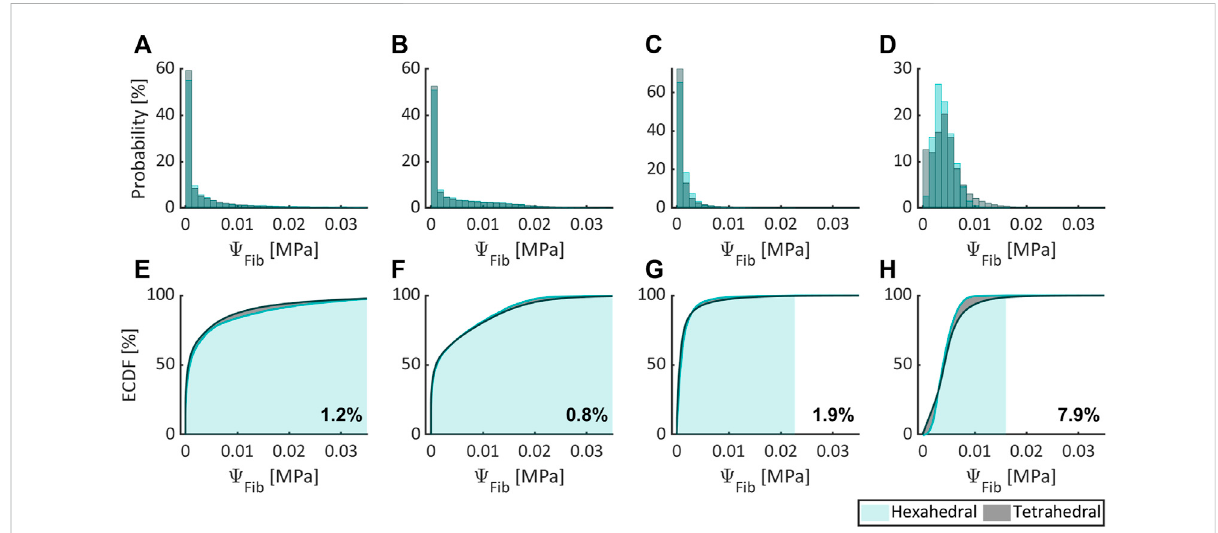
FIGURE 7 ComparingtheanisotropiccontributiontotheSEDFexpressedasprobability(normalizedhistogram)andECDFfor fl exion (A,E) ,extension (B,F) , lateral bending (C,G) , and axial rotation (D,H) for HE and TE types.